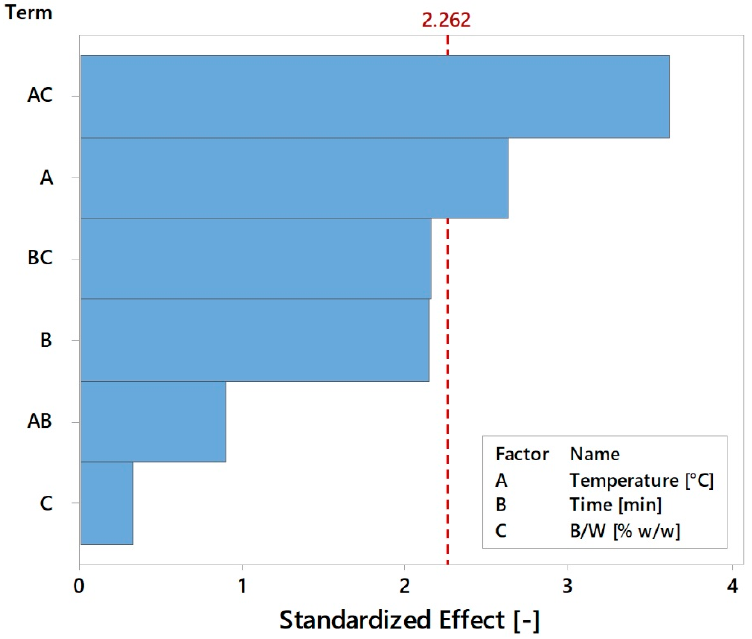
Figure 7. Normal plot of the standardized effects for total biocrude yield.